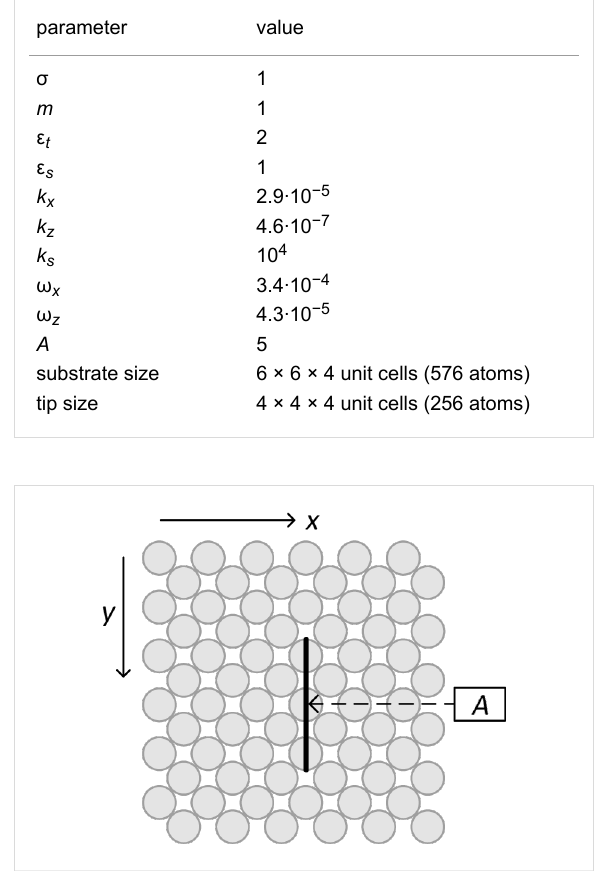
Figure 2: Top view of the substrate surface for the Lennard-Jones case. Distance dependence is probed at position A, whereas constant height scans are performed along the sketched